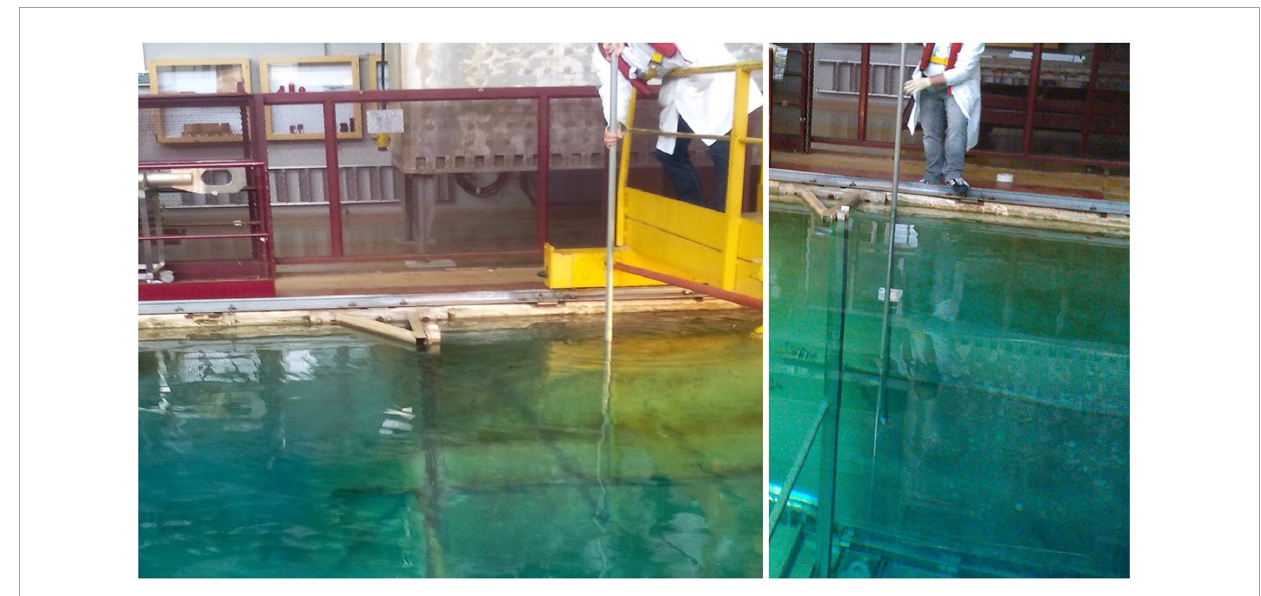
FIGURE1 Surface of the water pool that was sampled. The pictures show the biofilm sampling on the north wall using the pole with the scraper sponge attached (credit: Corinne Rivasseau).